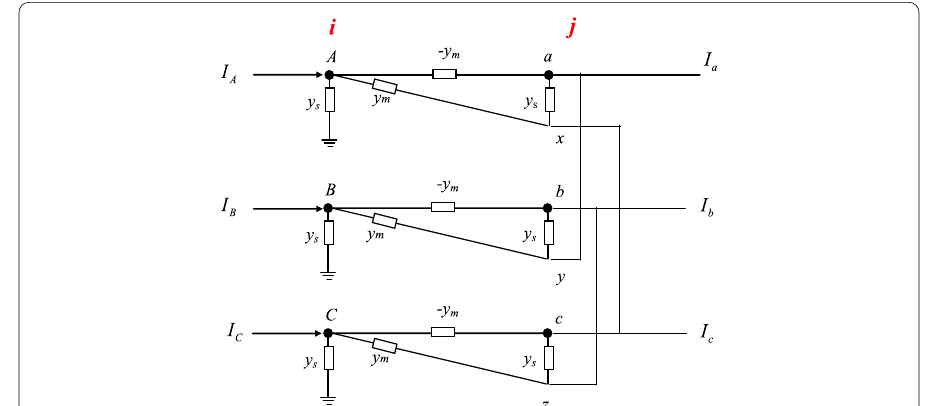
Fig. 10 Topology network of the transformer by ignoring mutual-inductances; Topology network of the transformer by ignoring mutual-inductances is showed in the connection of YN,d11